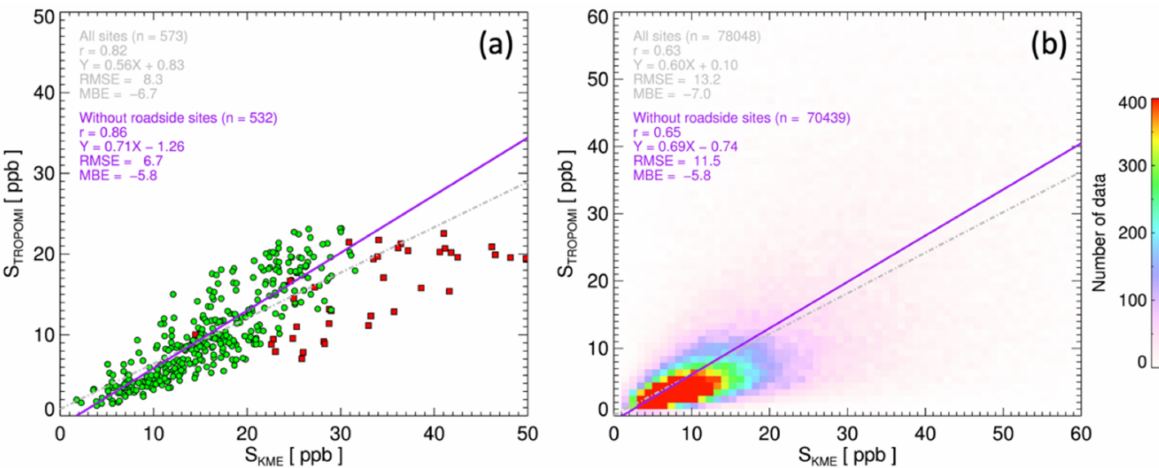
Figure 8. Comparison of surface NO 2 mixing ratio estimated from TROPMI and measured from KME stations over South Korea for 2019. Panel ( a ) compares annual mean values at KME stations, and panel ( b ) compares all collocated samples. Green circles in panel ( a ) represent ambient monitoring stations, and red rectangles indicate roadside sites.